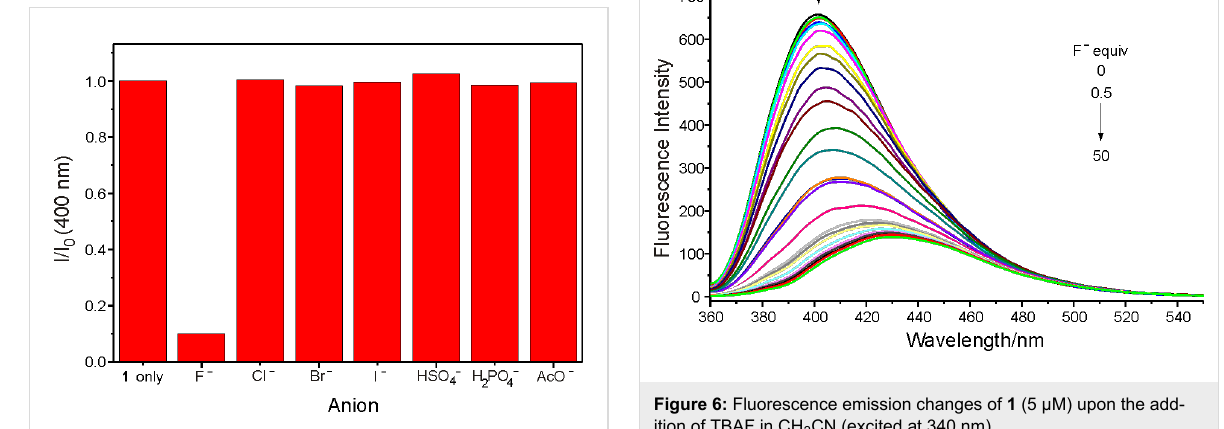
For some receptors, the presence of H 2 PO 4 − and AcO − inter- feres with the detection of F − [13]. However, in the case of receptor 1 , addition of the same equiv amount of H 2 PO 4 − or AcO − , as well as other anions such as Cl − , Br − , I − and HSO 4 − , did not lead to quenching of the fluorescent emission (Figure 4). The results indicate that the receptor 1 is a good sensor for recognizing F − over other anions.